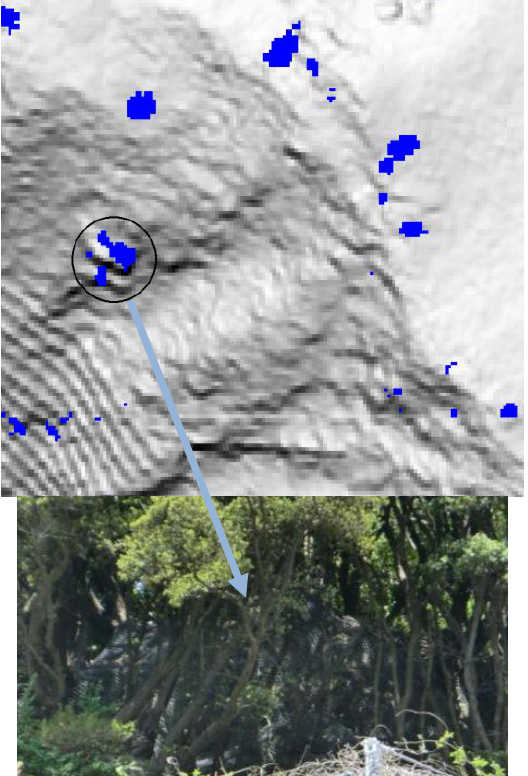
Figure 4. Blue patches are the protruding rocks, at region B, detected by the proposed algorithm. Detected rock enclosed in the circle was found to be about 5 m wide confirmed by the field verification